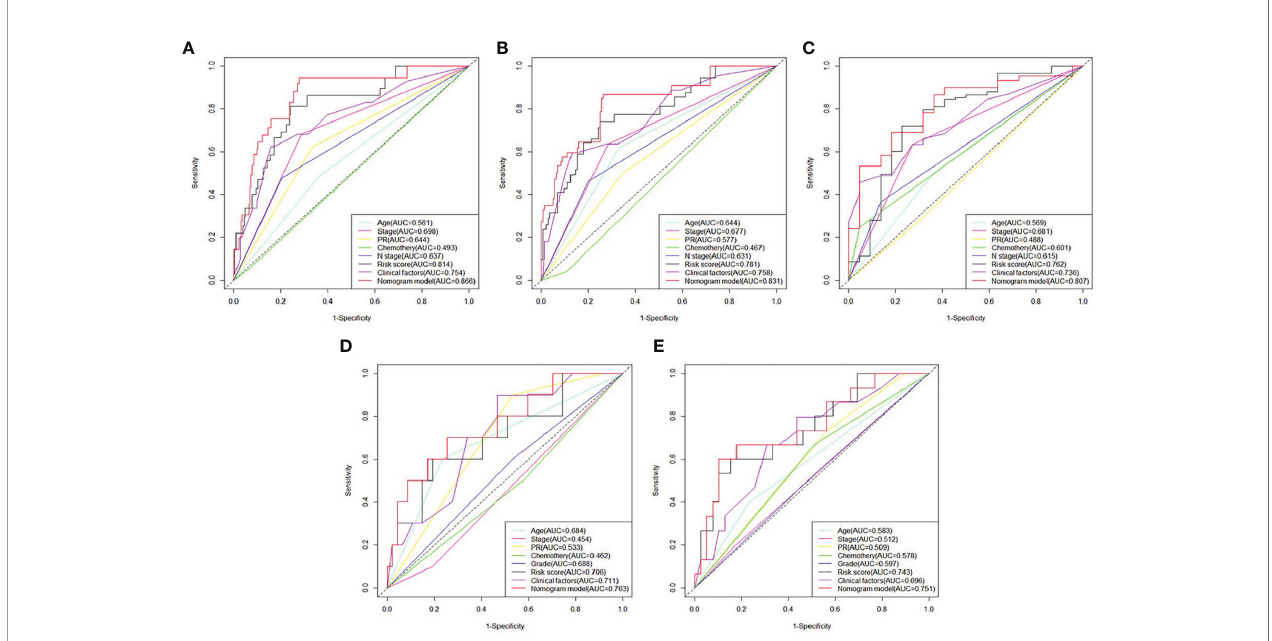
FIGURE 8 | Comparison between survival prognosis gene signature and clinical factors. (A) Multivariate ROC curves for 3-, (B) 5-, and (C) 10-year survival in developed dataset. (D) Multivariate ROC curves for 3- and (E) 5-year survival in validation dataset.